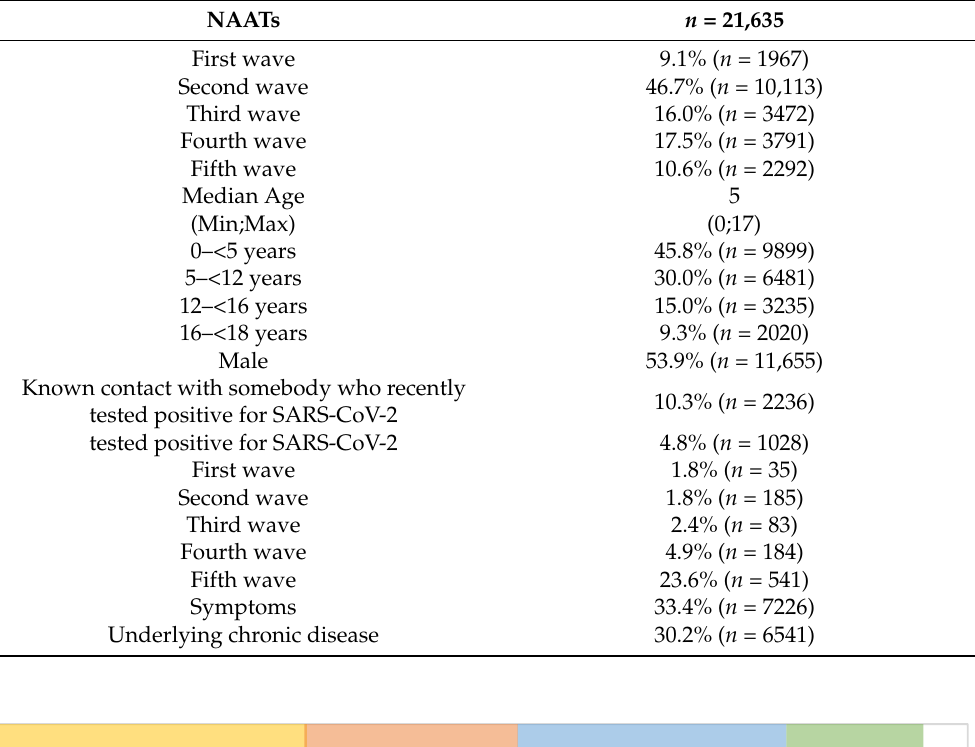
Table 2. Demographic data from n = 21,635 SARS-CoV-2 nucleic acid amplification tests (NAATs) on children and adolescents between the age of 0 and 18 years.